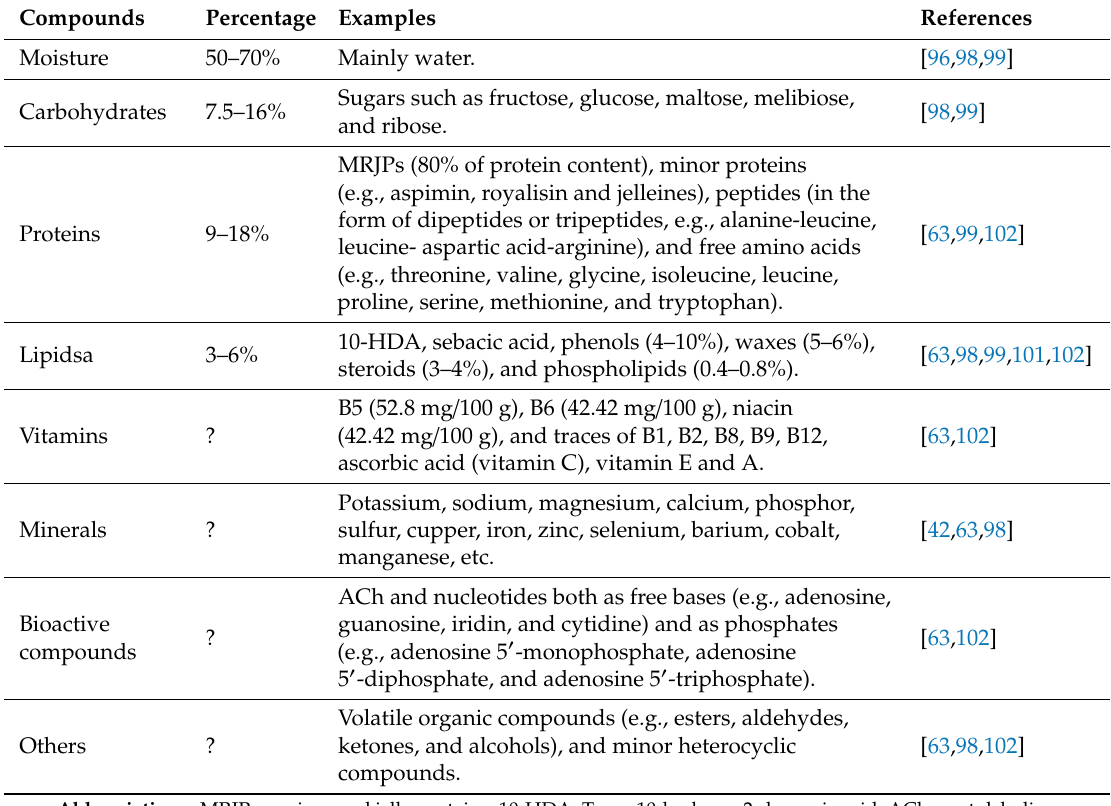
Table 1. Composition of royal